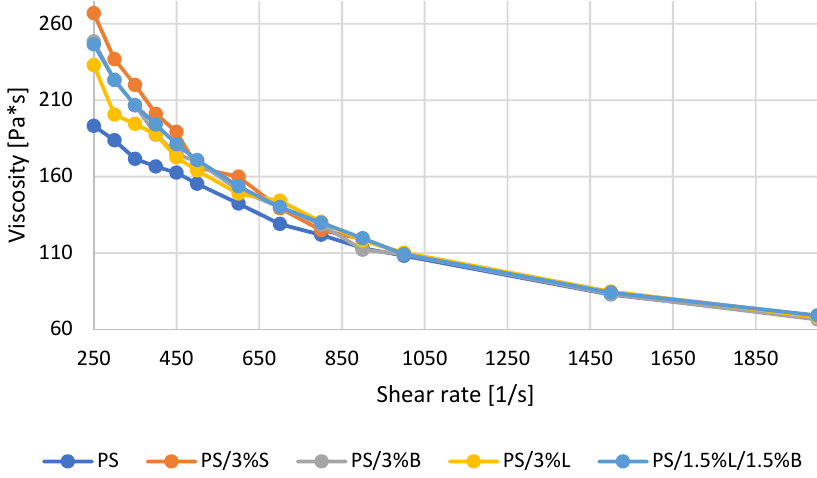
Figure 3. Viscosity curves of PS polymer and composites based on PS.